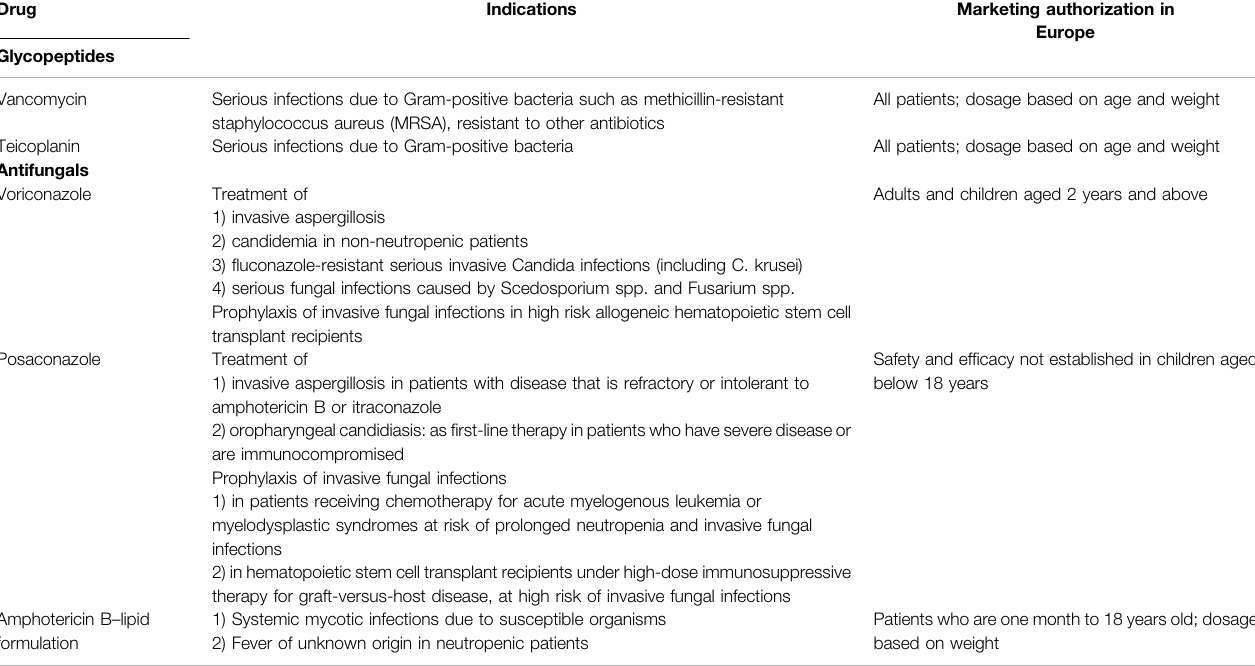
TABLE 1 | Indications and European marketing authorization status of glycopeptides and antifungals in the different paediatric age groups. Drug